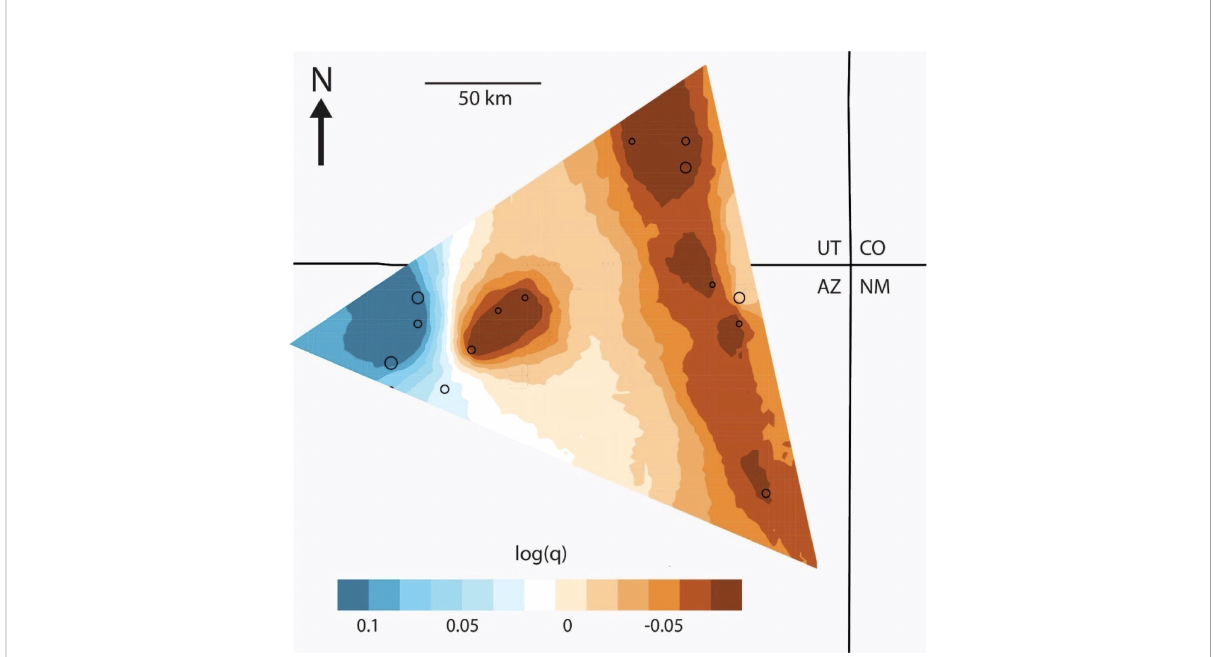
FIGURE 4 Effective diversity surface estimated with EEMS (200 demes) where blues indicate regions of relatively high effective diversity ( q ) and oranges indicate regions of relatively low effective diversity (here, log 10 ( q ) = 0.1 indicates ca. 26% higher diversity compared to the average across the range; Petkova et al., 2016). Circles indicate occupied deme localities with the size of the circle scaled to the number of